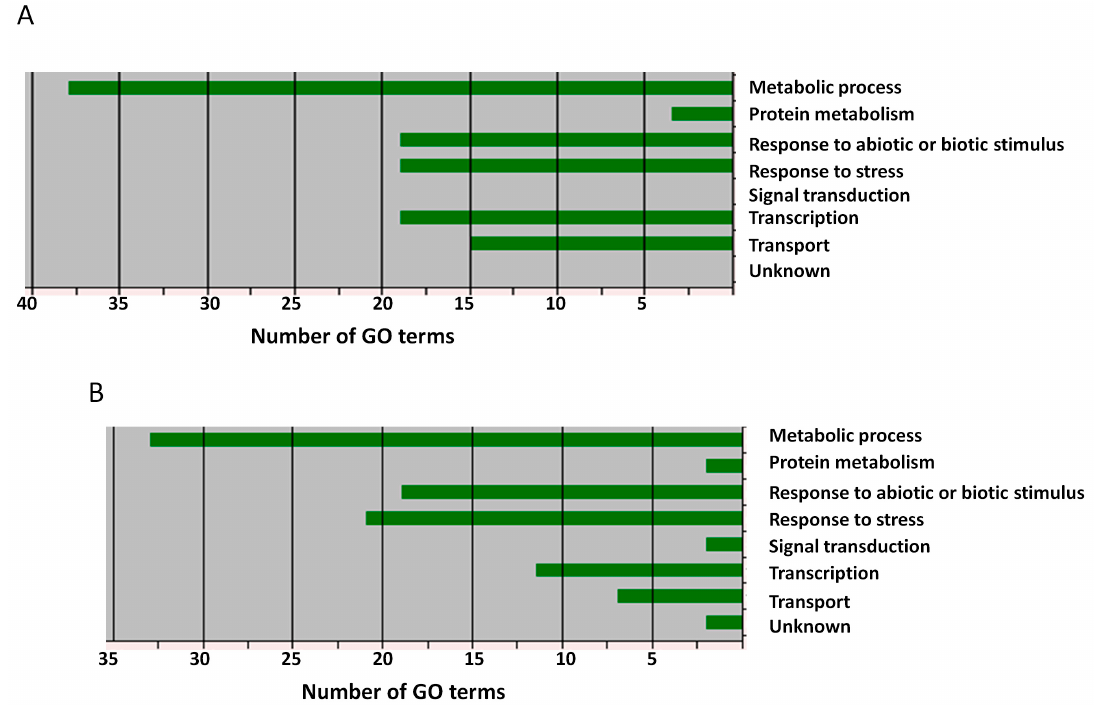
Figure 7. Biological process enrichment of the putative candidate genes. ( A ) PEG-induced drought stress; ( B ) NaCl-induced salt stress. GO: Gene Ontology Table 4. SNPs significantly associated with NaCl-induced salt tolerance indexes at the germination stage in sesame.